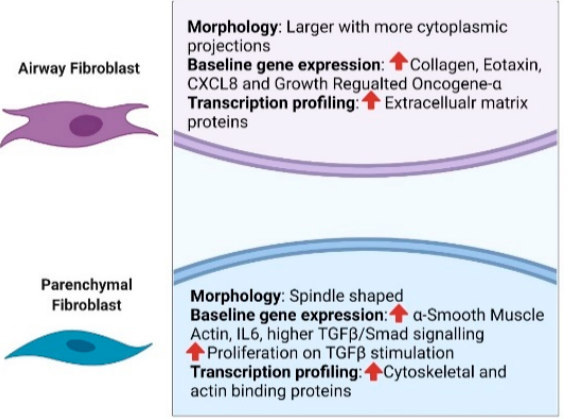
Figure 1. Distinction between airway and parenchymal fibroblasts based on morphology, baseline expression of distinct genes and pathways associated with transcription profile. Created with BioRender.com, accessed 25 July 2021.